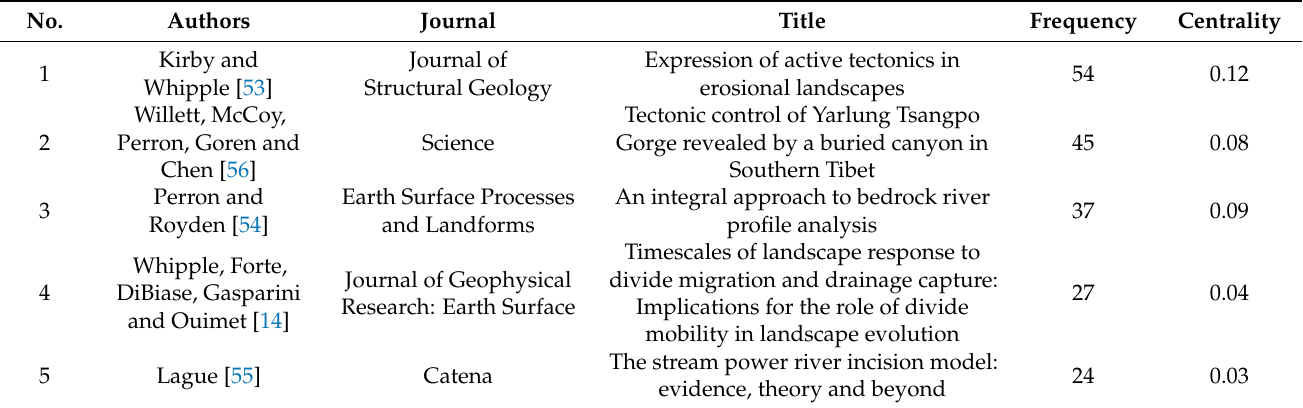
Table 7. Top 5 citations in tectonic geomorphology research from 1981 to